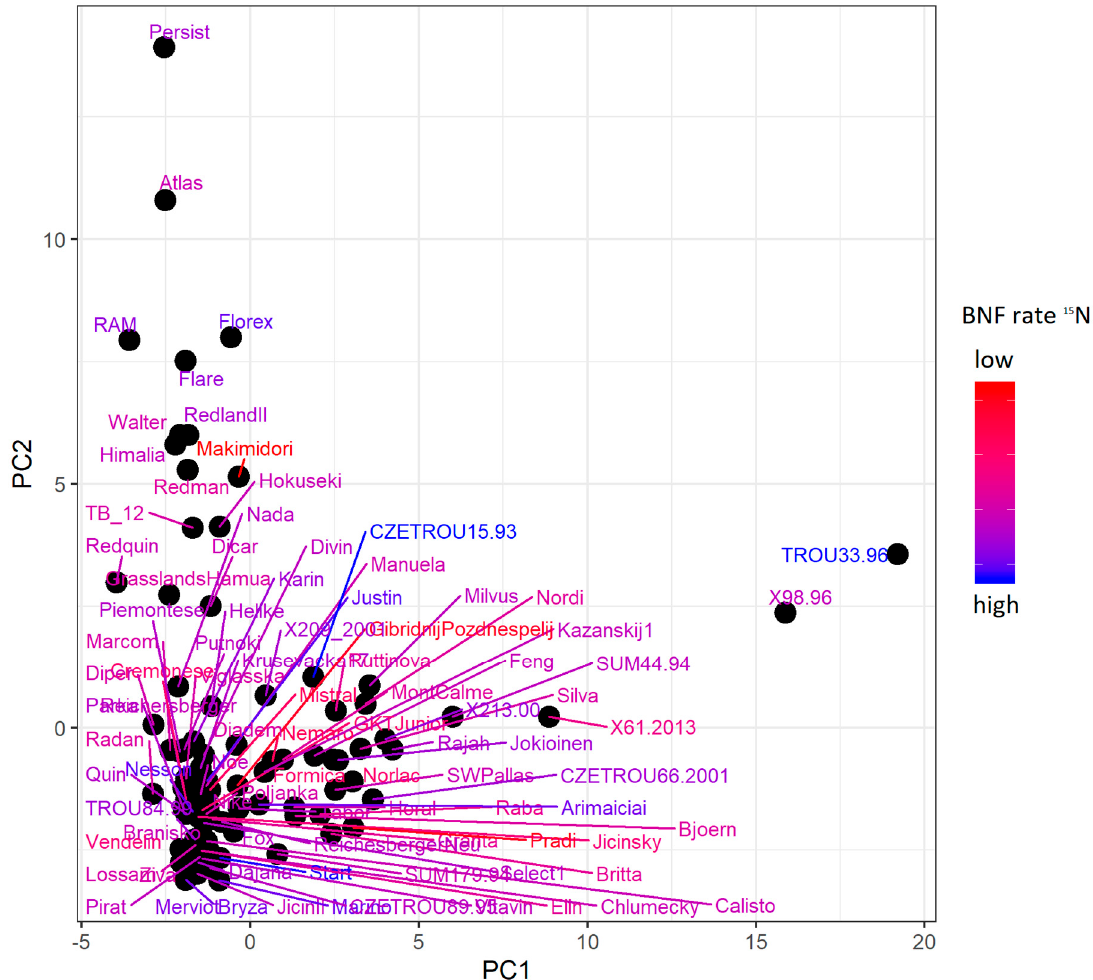
Figure 7. Principal component analysis (PCA) plot of genetic structure of genotype data using 91 samples from red clover populations. PC1 and PC2 indicate principal components. Color scale shows delta 15 N value that corresponds to biological nitrogen fixation (BNF) level (red color indicates low BNF level, blue indicates high BNF level).